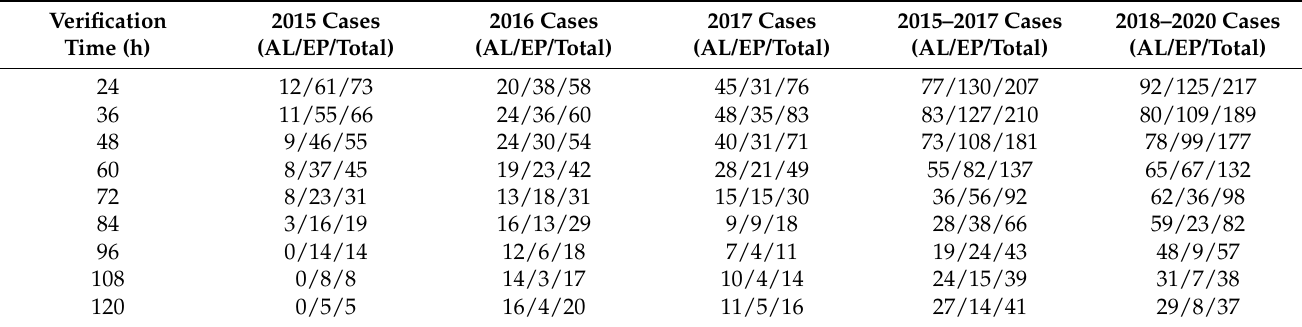
Table 10. Number of cases satisfying the HFIP RI performance measure sample requirements during the baseline period (2015–2017) and subsequent three years, showing the contributions to the sample from the Atlantic (AL) and eastern North Pacific (EP)